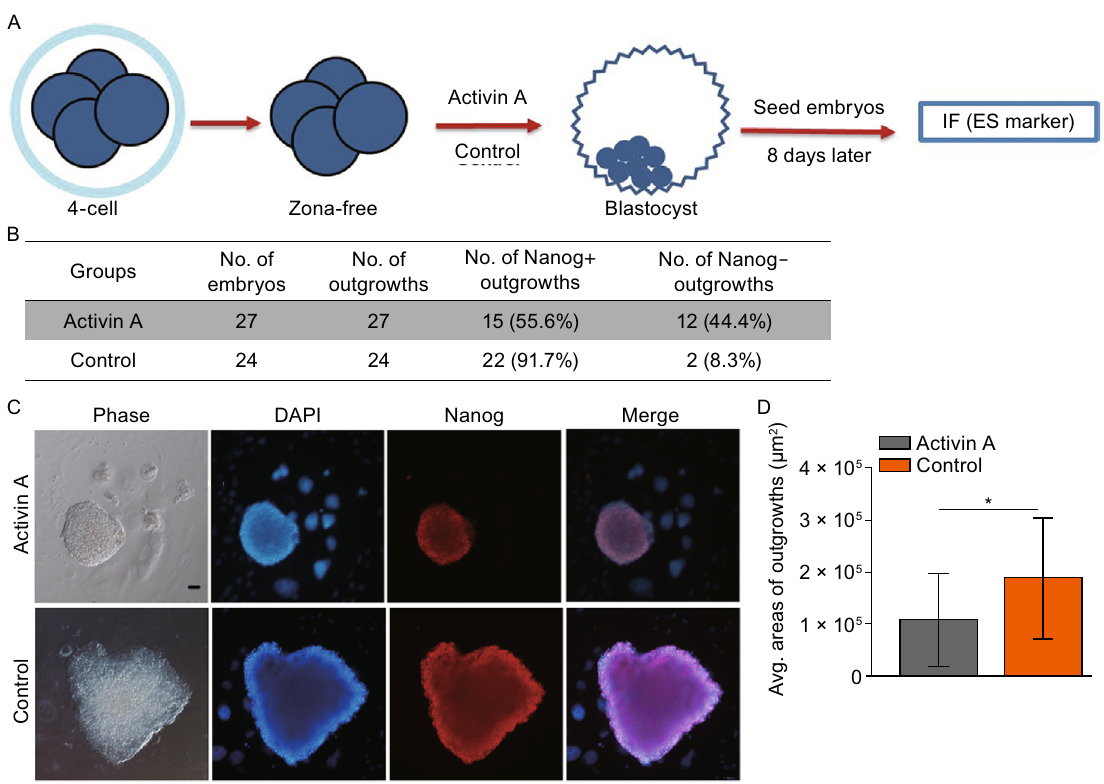
Figure 4. Activin A has a negative effect on the derivation of ESCs. (A) Experimental design for outgrowth analysis. Activin A treated-embryos were seeded on the feeder cells at E4.5 and then immunostained 8 days later to test whether Acticin A has effects on ES cell isolation. (B) Summary of outgrowths derived from Activin A treated and untreated late blastocysts. P < 0.05 by Chi-square test. (C) Nanog immunostaining in outgrowths derived from Activin A treated and untreated blastocysts. Nuclei were stained with DAPI (Blue). Scale bars, 50 μ m. (D) Average areas ( μ m 2 ) of Nanog positive outgrowths. Error bars indicate SD. * P < 0.05